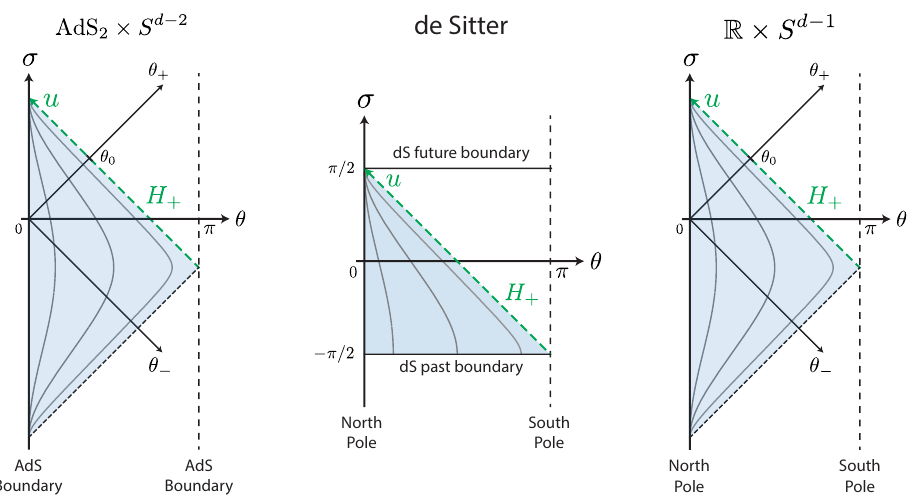
Figure 1 . Penrose diagrams associated to AdS 2 × S d − 2 , de Sitter and the Lorentzian cylinder R × S d − 1 . The coordinates ( u, ρ ) only cover the shaded blue region in each case, where several constant ρ trajectories are sketched in gray. Future null infinity at ρ = 0 in Minkowski is mapped to the future horizon H + indicated with a dashed green